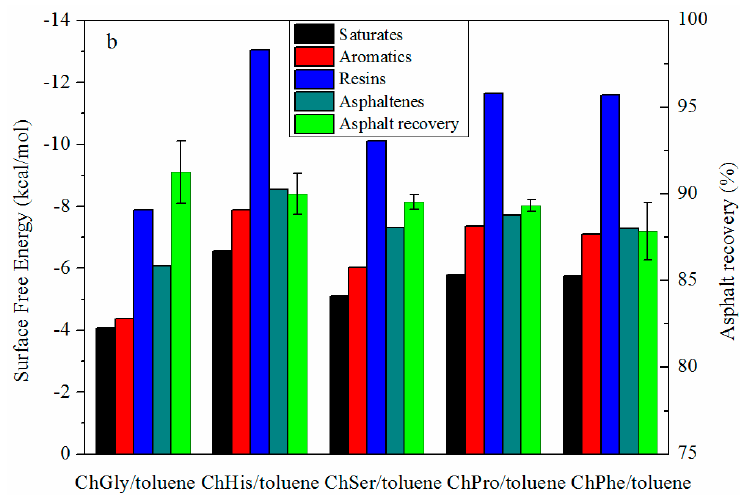
Figure 7. Surface free energies of different SARA molecules at specific interfaces with the corresponding asphalt extraction recovery: ( a ) IL-SARA fraction interfaces and ( b ) toluene-IL interfaces.